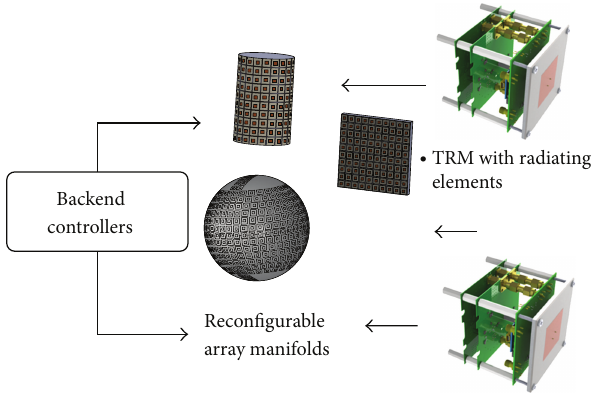
Figure 1: The CPAD concept.